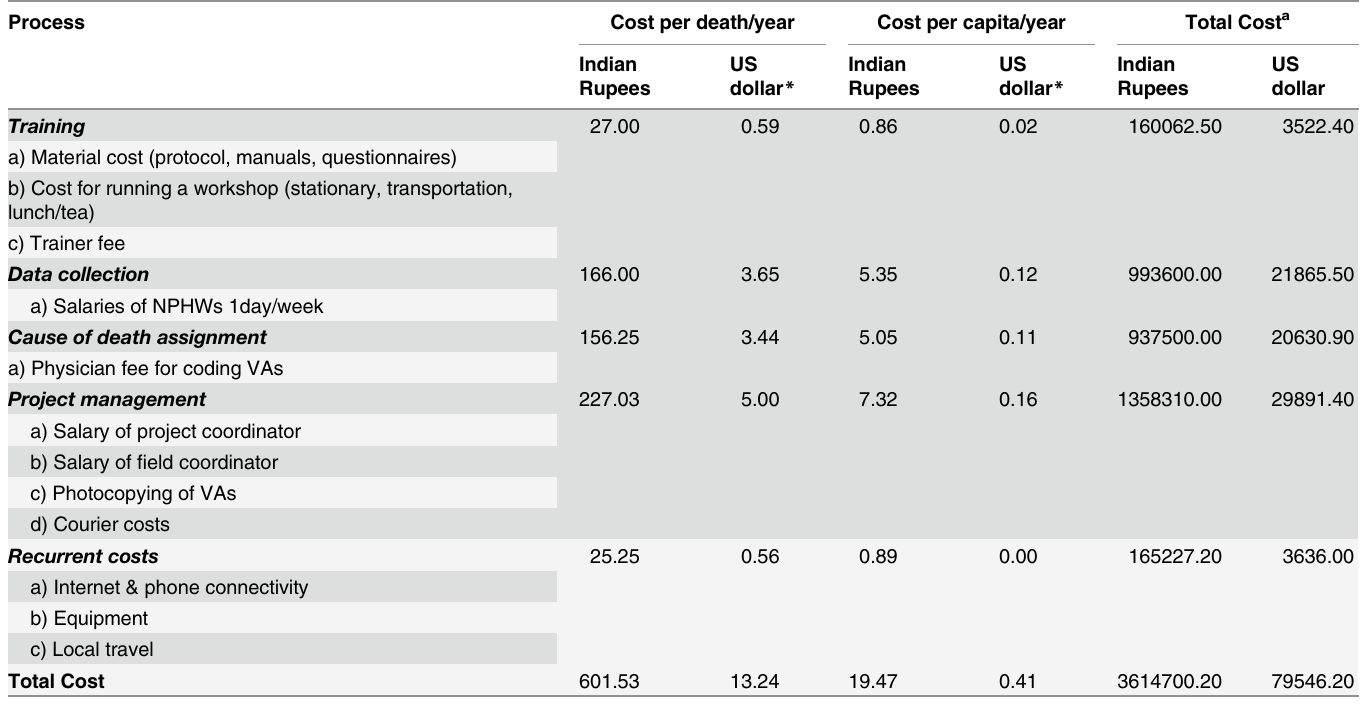
Table 3. Total cost for running the surveillance system over four